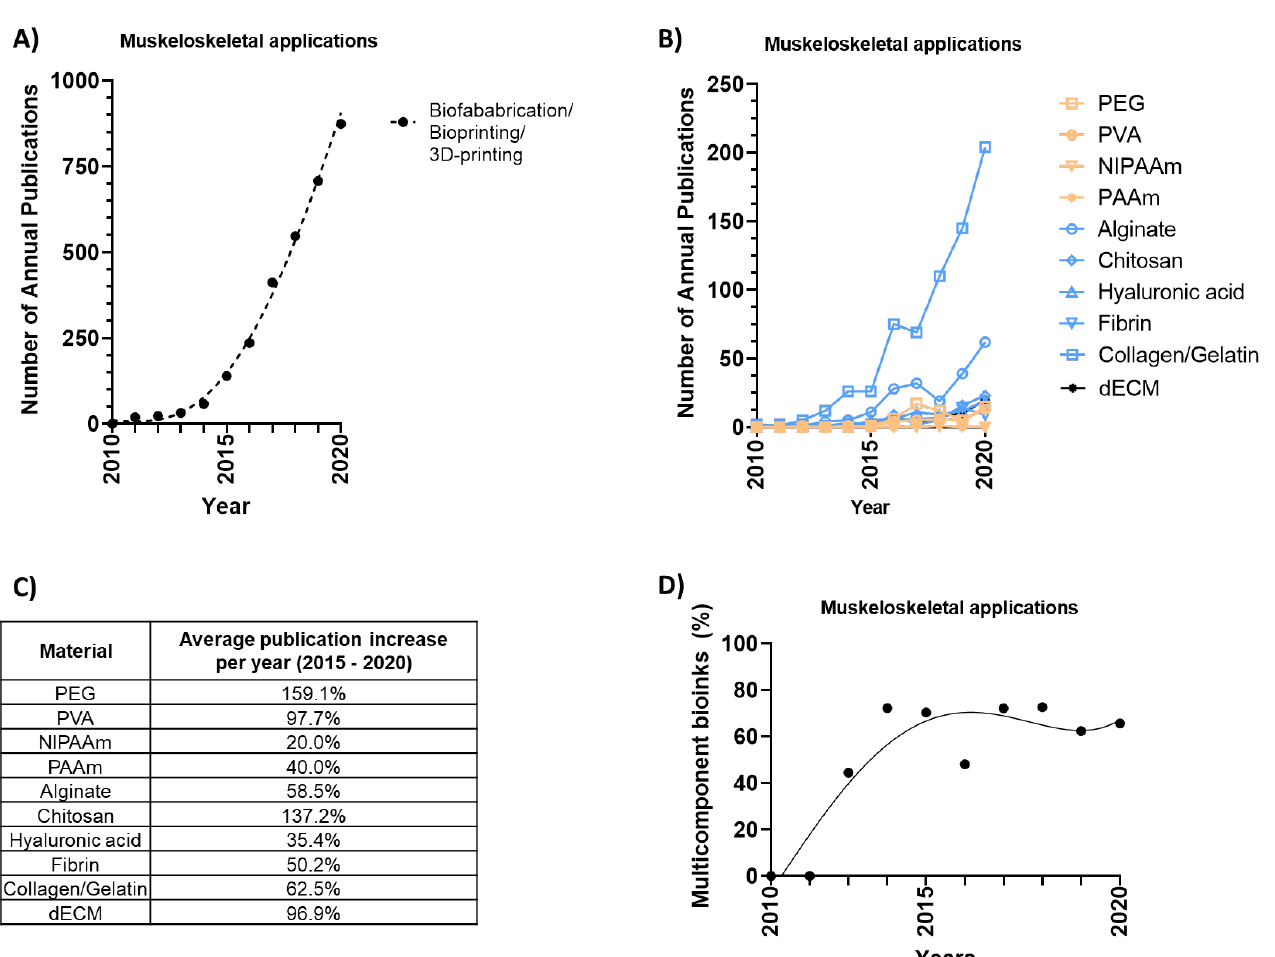
Figure 2. Analysis of publications within the field of musculoskeletal biofabrication over the past decade. An exponential increase in the total number of publications can be observed between the years 2010 and 2020 ( A ). There is a preference for using naturally derived polymers as bioink components over synthetic materials ( B ). While the use of both collagen/gelatin and alginate-based bioinks has generated the highest interest overall, the use of both PEGs and chitosan has increased the most in the past 5 years ( C ). The field has steadily moved from single component bioink formulations to more complex multicomponent structures ( D ).